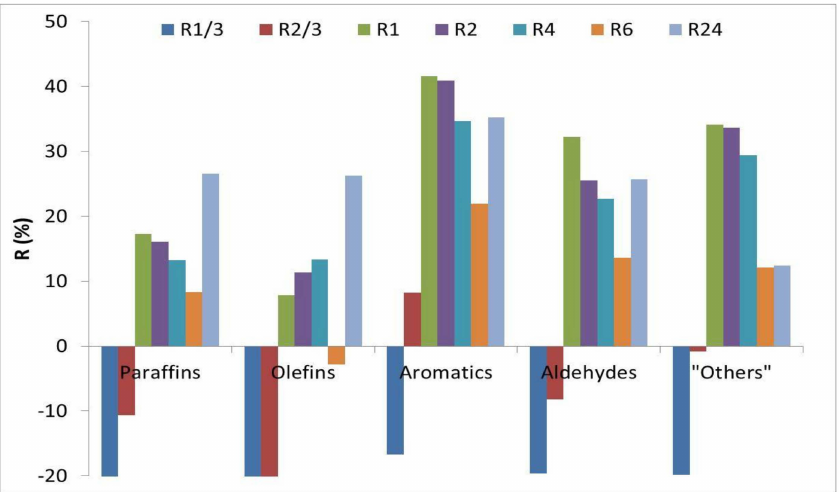
Figure 13. Reductions of the groups of compounds considered in the gas fraction vs. reaction time.